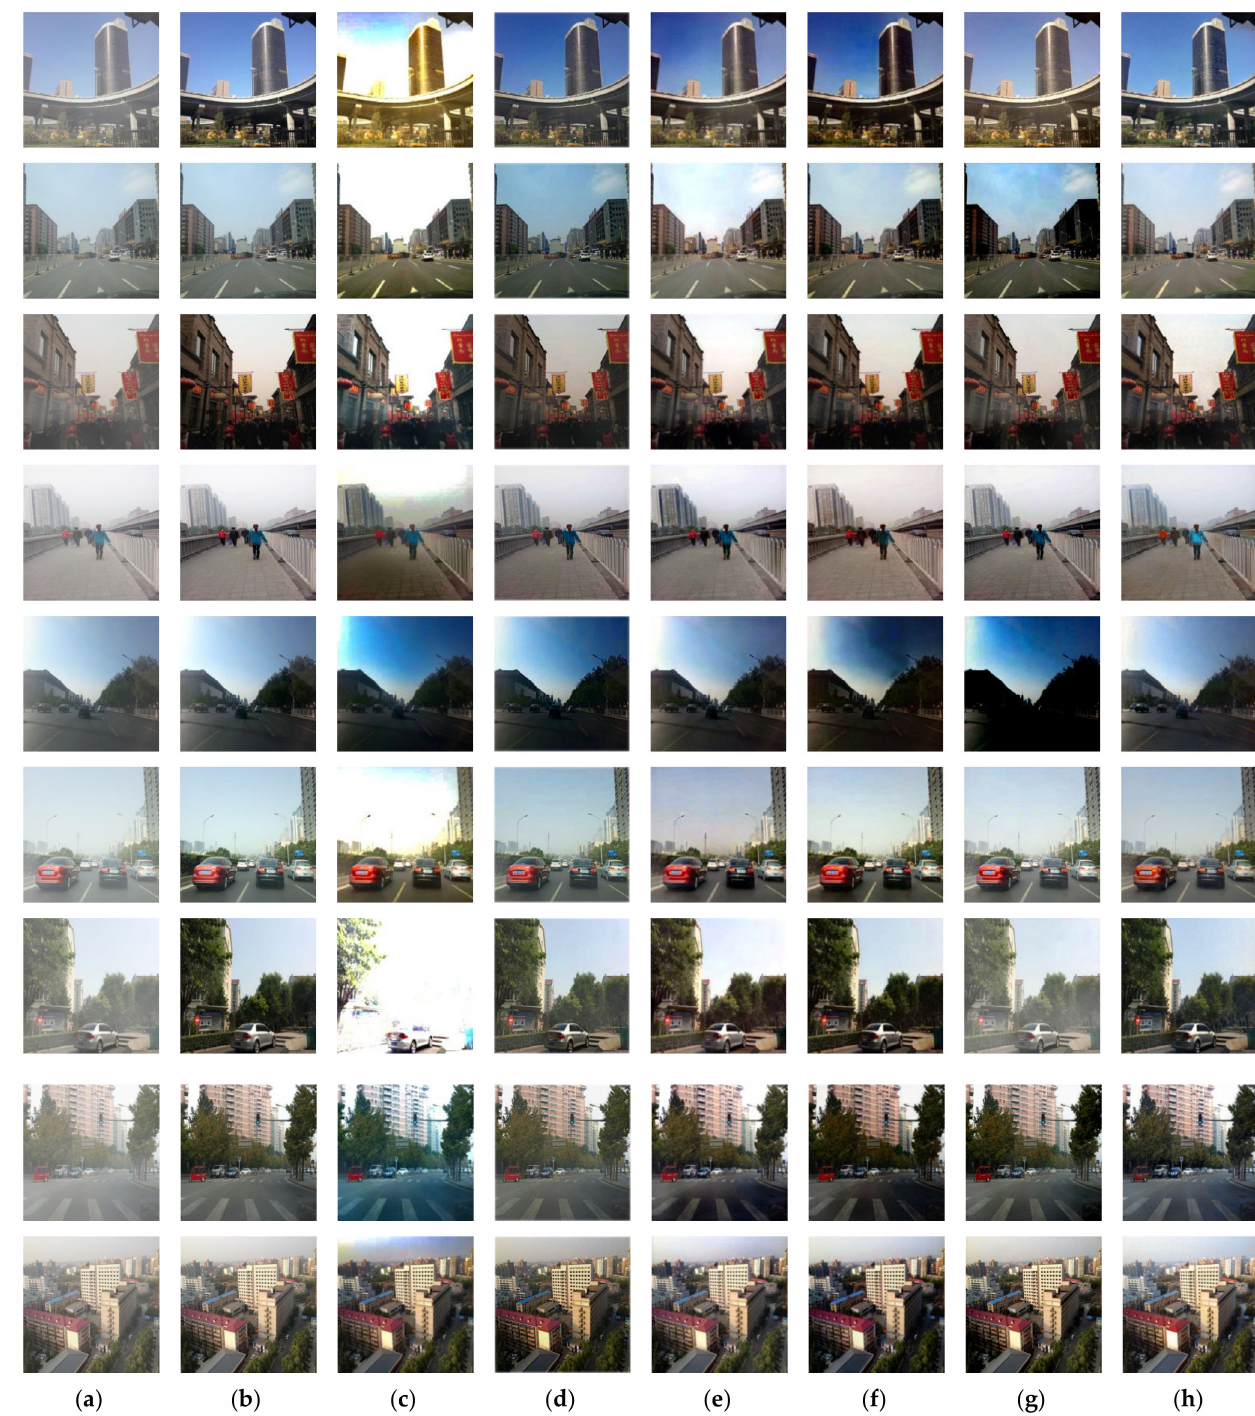
Figure 8. Visual results on the SOTS dataset: ( a ) hazy images; ( b ) corresponding haze-free images; ( c ) DCP; ( d ) AOD-Net; ( e ) GCANet; ( f ) EPDN; ( g ) YOLY; ( h ) proposed